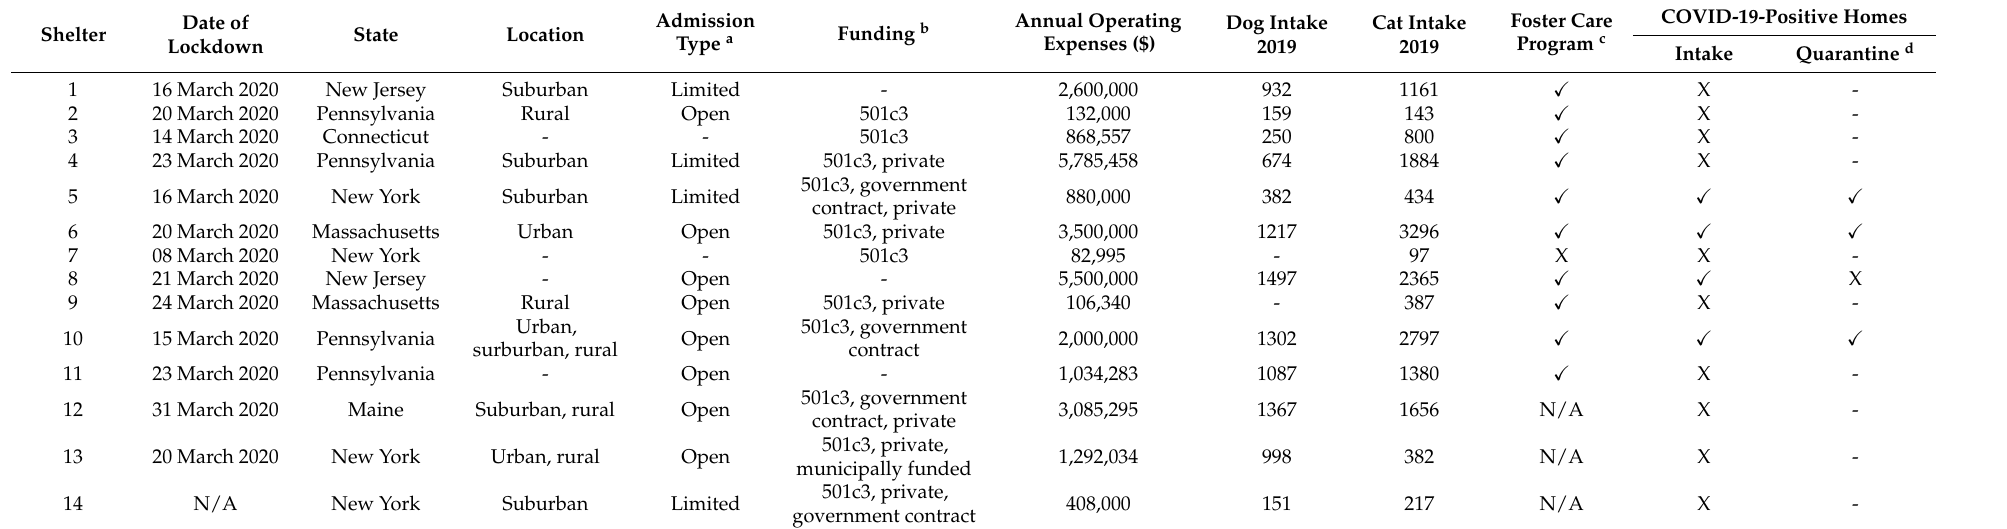
Table 1. Descriptive characteristics of shelters ( n =